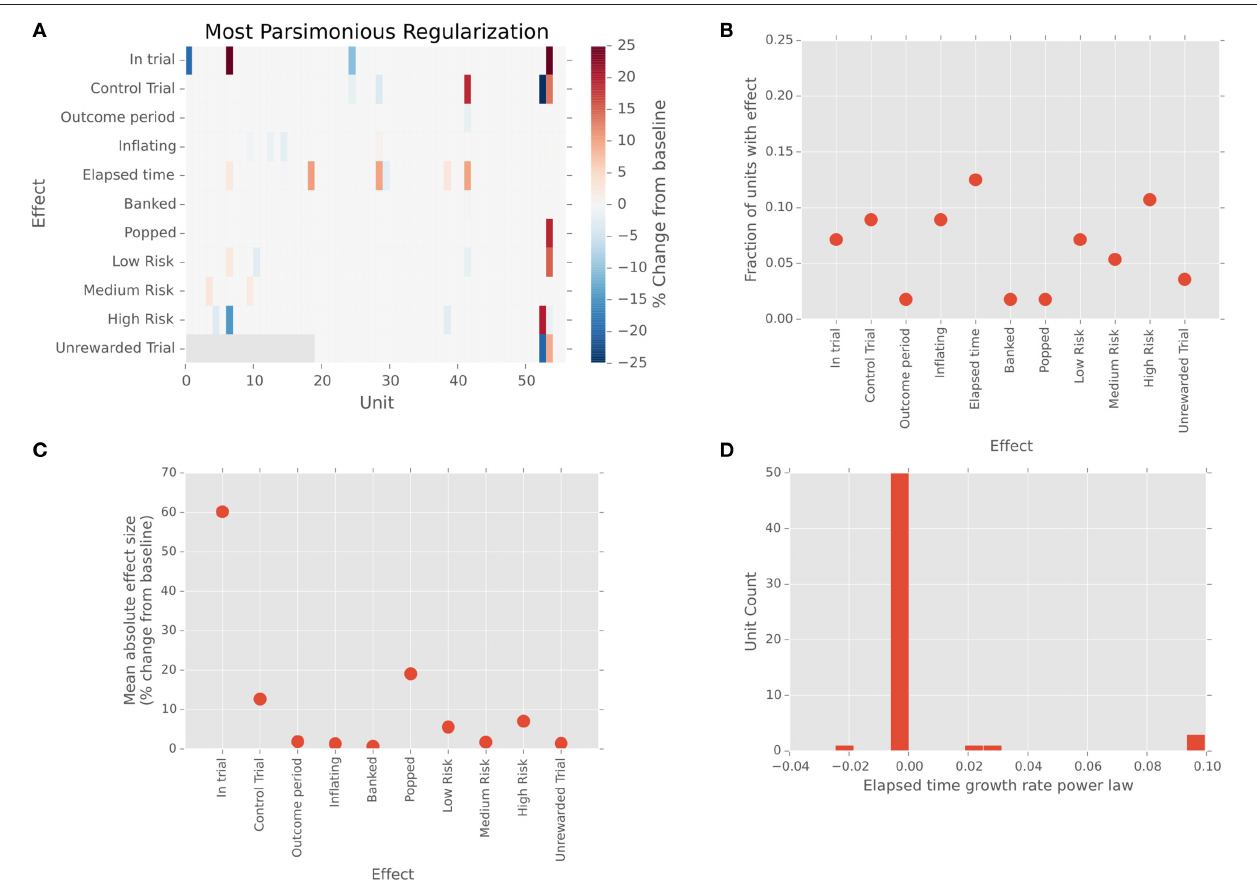
FIGURE 2 | Single units in STN show sparse responses to task variables. (A) Effect sizes for each unit and task variable in the firing rate model. Neutral colored tiles indicate no effect. Colors indicate percent change in firing relative to inter-trial baseline. (B) Fraction of units exhibiting each effect. (C) Mean absolute effect size (percent change from baseline) across units in which that effect was present in the model. (D) Change in firing rate over time. Histogram of firing rate effect, expressed as percent change relative to baseline. Effects are calculated for a representative elapsed time of 5s, based on the fitted exponent gamma in the power-law growth model f = α ( t − t 0 + 1) γ